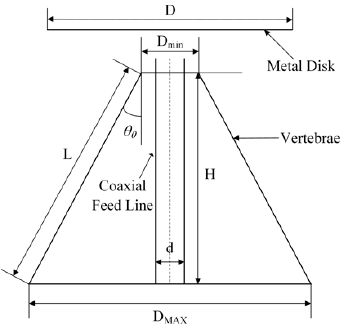
Figure 2. Schematic diagram of discone antenna.